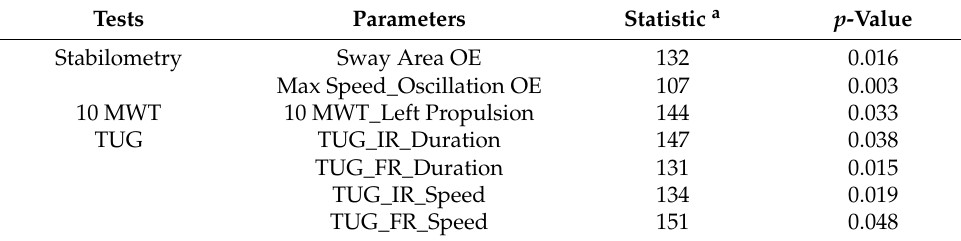
Table 3. Comparison between Fall and NFall groups.